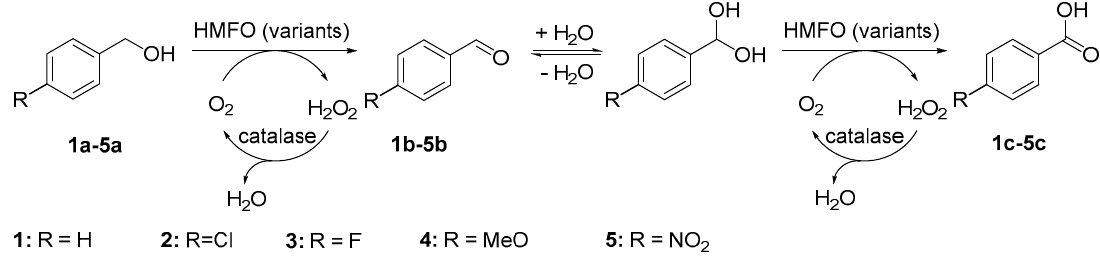
Figure 2. Oxidation of benzylic alcohols 1a – 5a (25 mM) by HMFO (wild type, 0.7 µM) in sodium phosphate buffer (100 mM, pH 7.0) at 30 °C with atmospheric oxygen in the presence of catalase after 24 h.